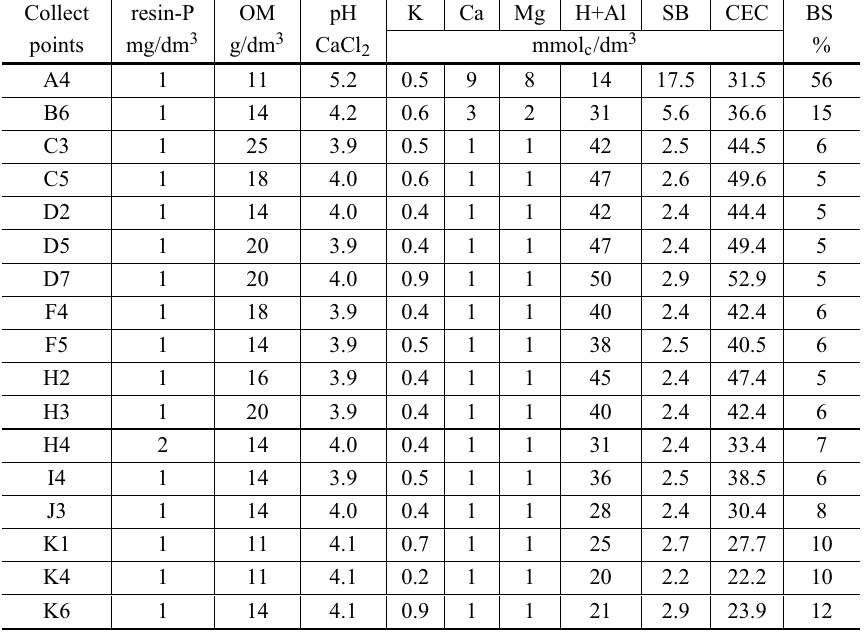
Variations in the chemical analysis of soil samples collected (0-40 cm) from the 17 collection points located in both physiognomies (Fig. 2). K, Ca, Mg, H+Al, SB and CEC values are expressed as base saturation